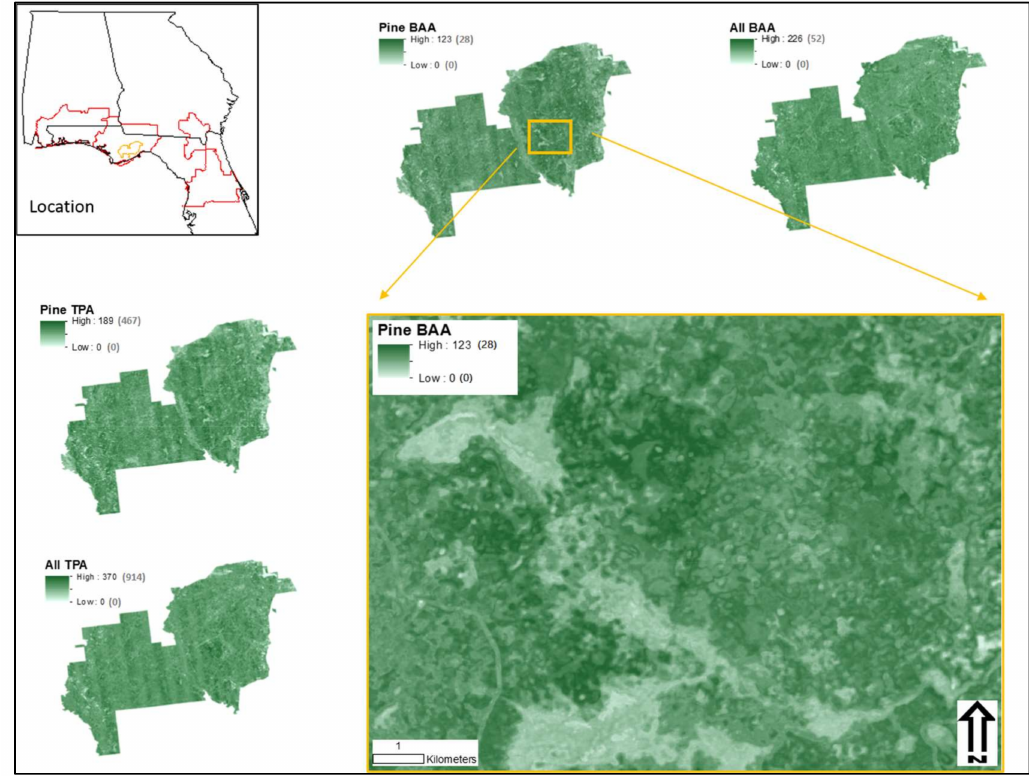
Figure 4. Example of basal area per acre (BAA; (m 2 per ha)) and trees per acres (TPA (trees per ha)) surfaces generated for the Apalachicola National Forest, which is a subset of the Apalachicola National Forest-St. Marks National Wildlife Refuge